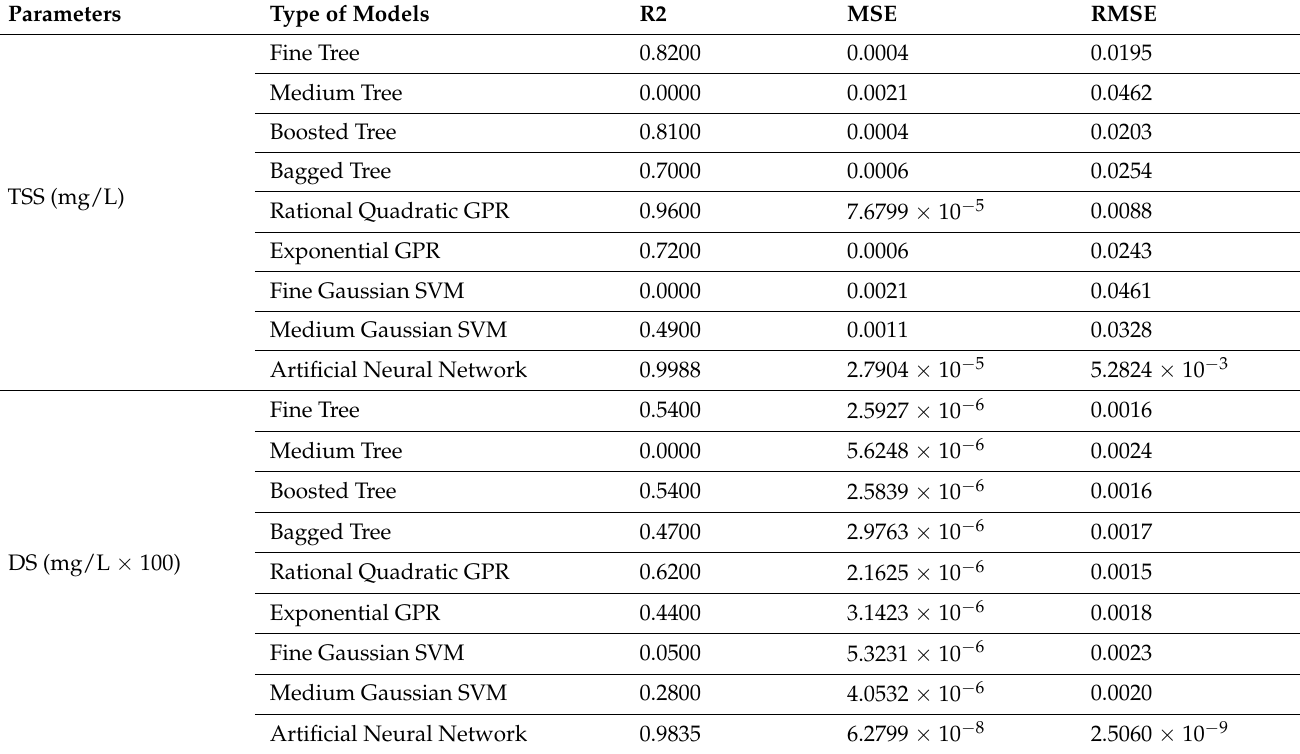
Table 3. Prediction analysis of all parameters (testing